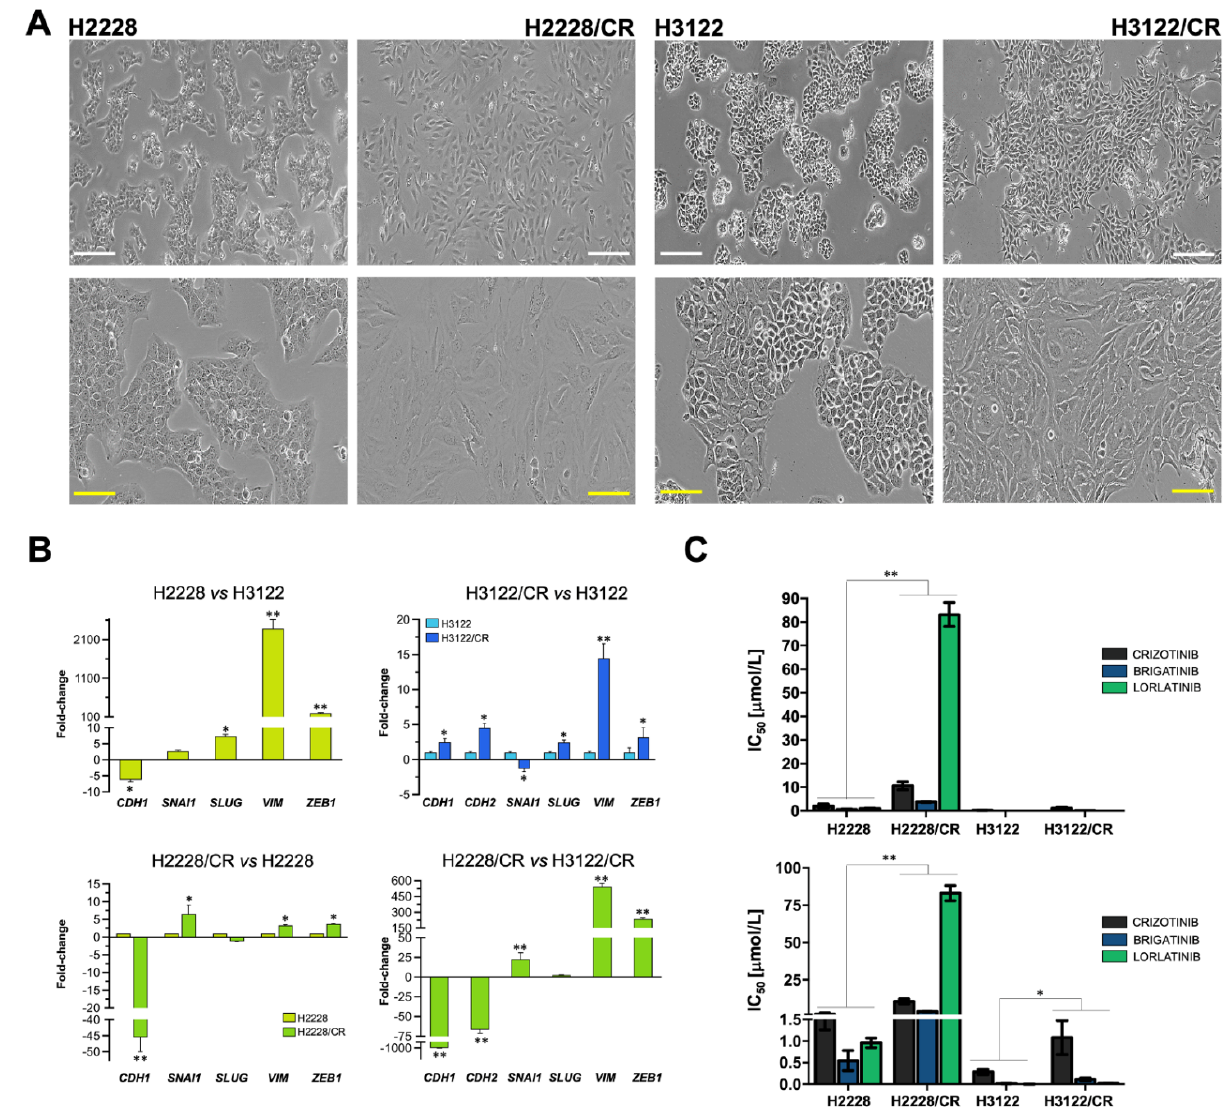
Figure 1. EMT-related traits in ALK-rearranged NSCLC cells with acquired cross-resistance to multiple-generation